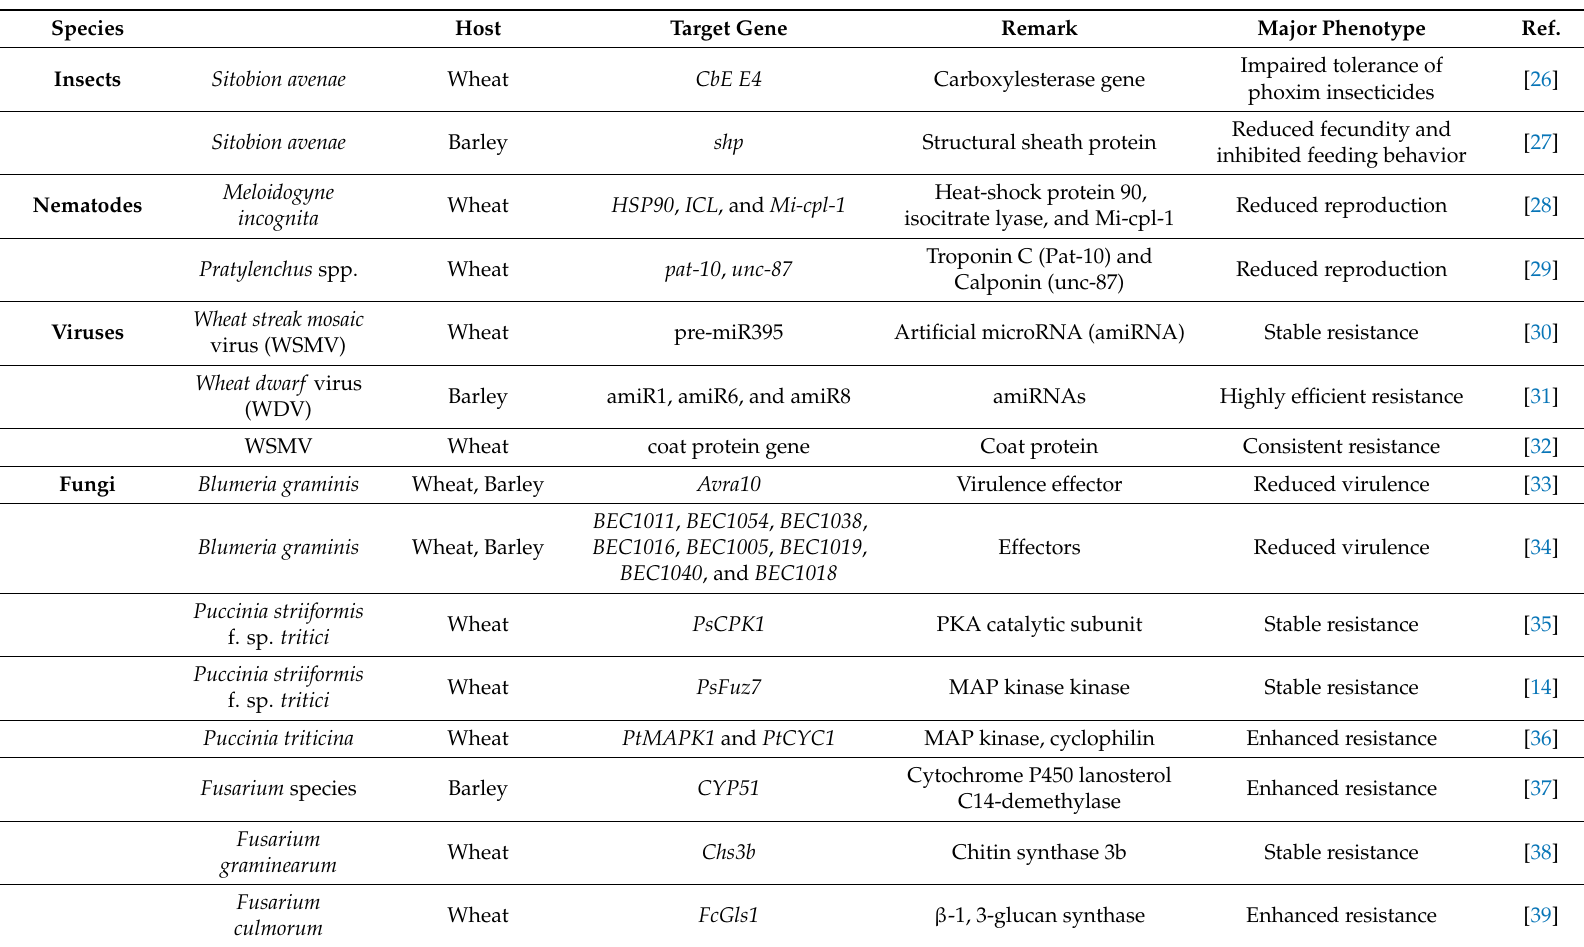
Table 1. Summary of study test in wheat and barley by using host-induced gene